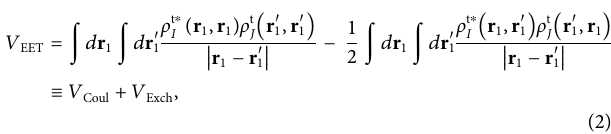
Frontiers in Molecular Biosciences |